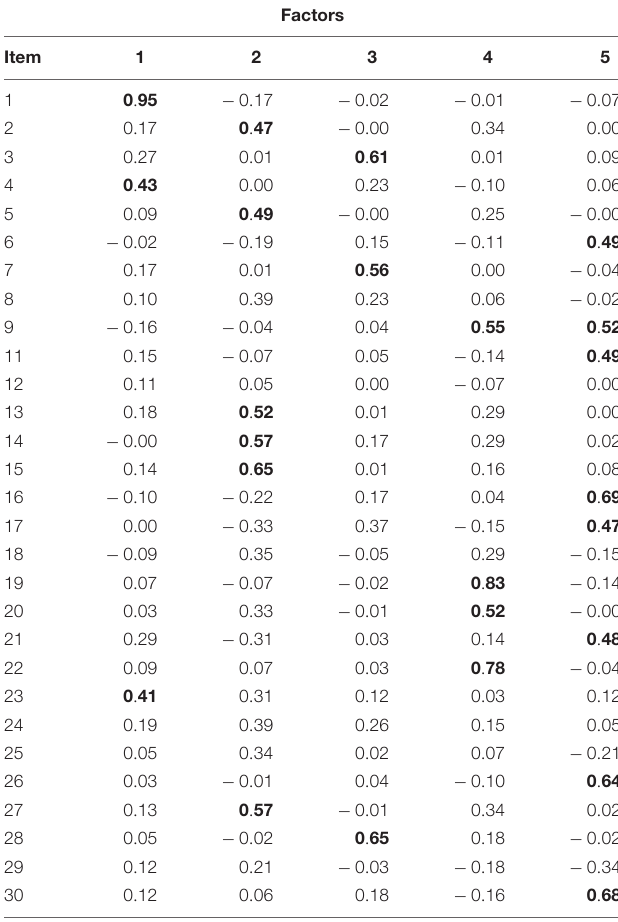
TABLE 2 | Model–data fit of exploratory structural equation modeling (ESEM) models.